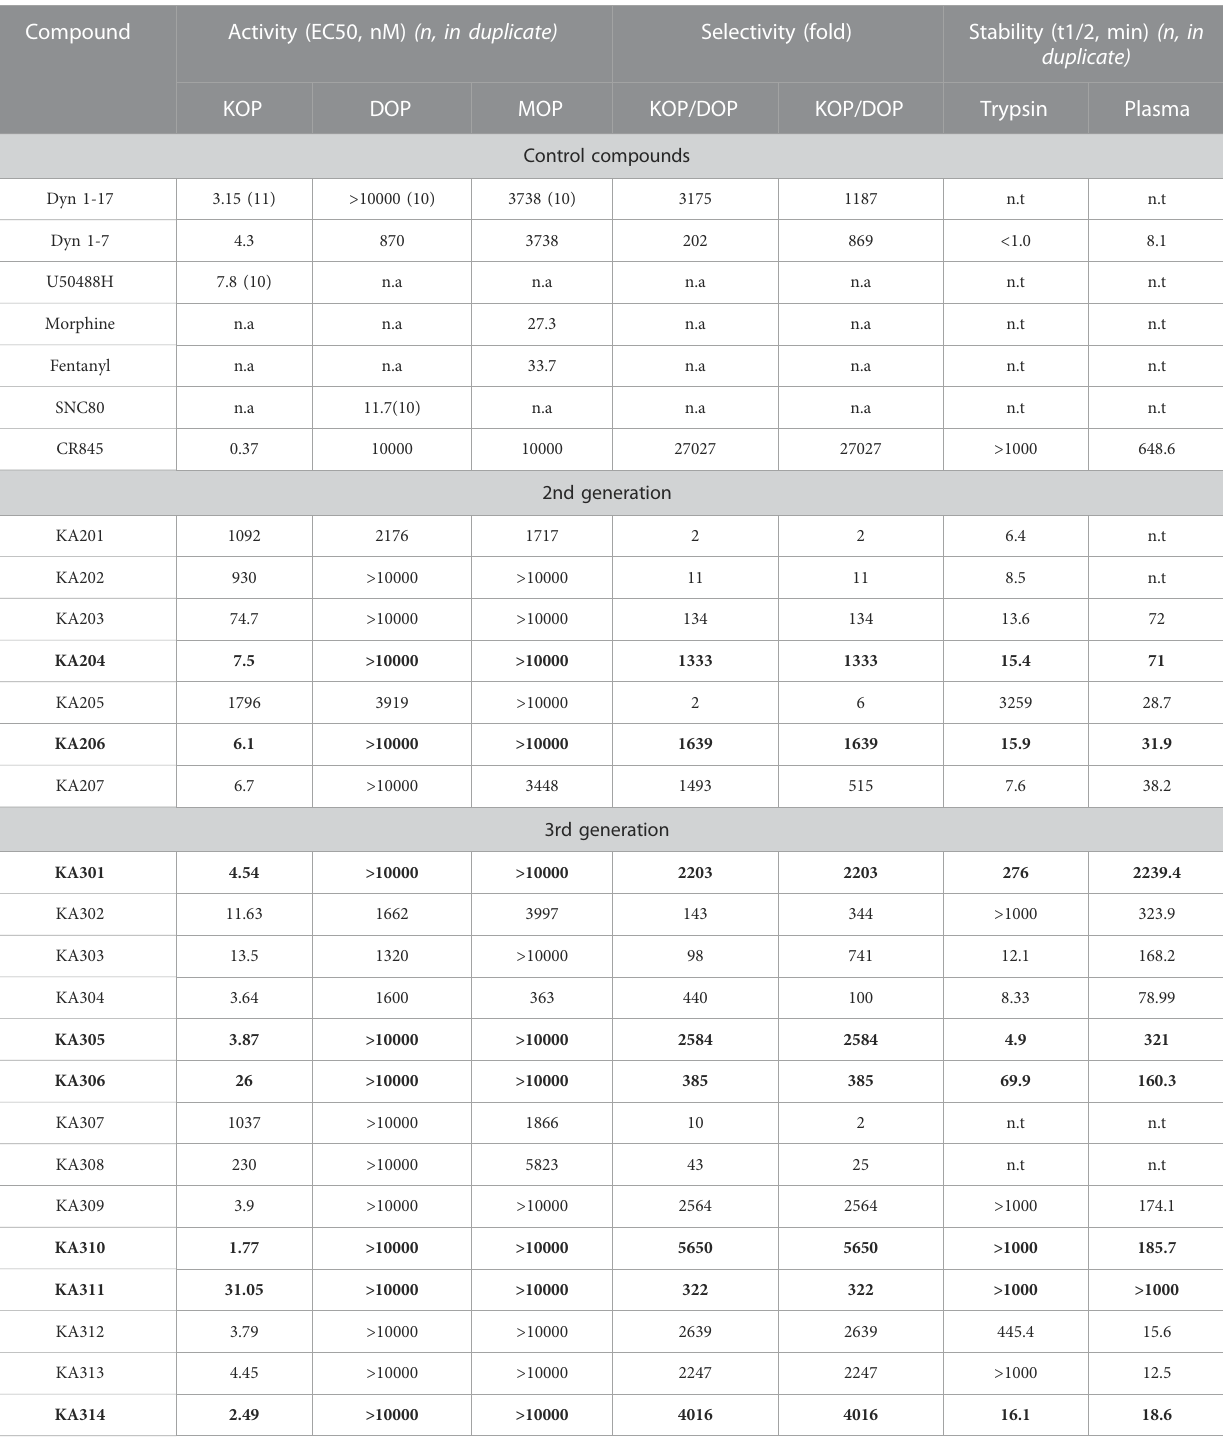
TABLE 1 Peptide and control compound in vitro properties. Activity (as EC 50 for cAMP, nM) of each control compound tested in KOP, DOP and MOP receptor over- expressing-HEK293 cells. Stability (as half-life, t 1/2 in minutes) tested in both trypsin and rat plasma. Compounds labelled in bold represent those with the most favourableselectivityofKOP(withlittletonorecordableactivityinMOPorDOP)for invivo testing.n.anotapplicable.n.tnottested.Datashownaremean±SEM; n = 3, in duplicate per data point, unless speci fi cally indicated in parenthesis.